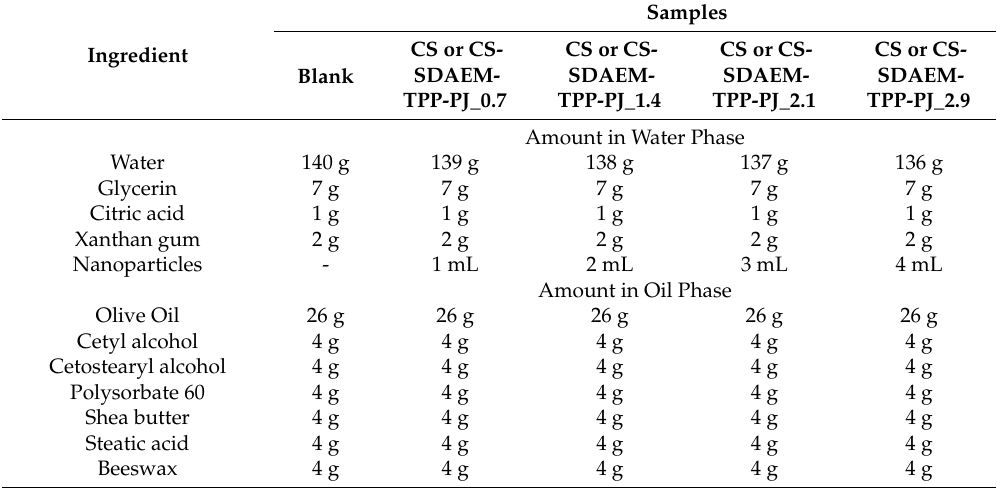
Table 1. List of ingredients used in the preparation of the emulsions (Water and Oil